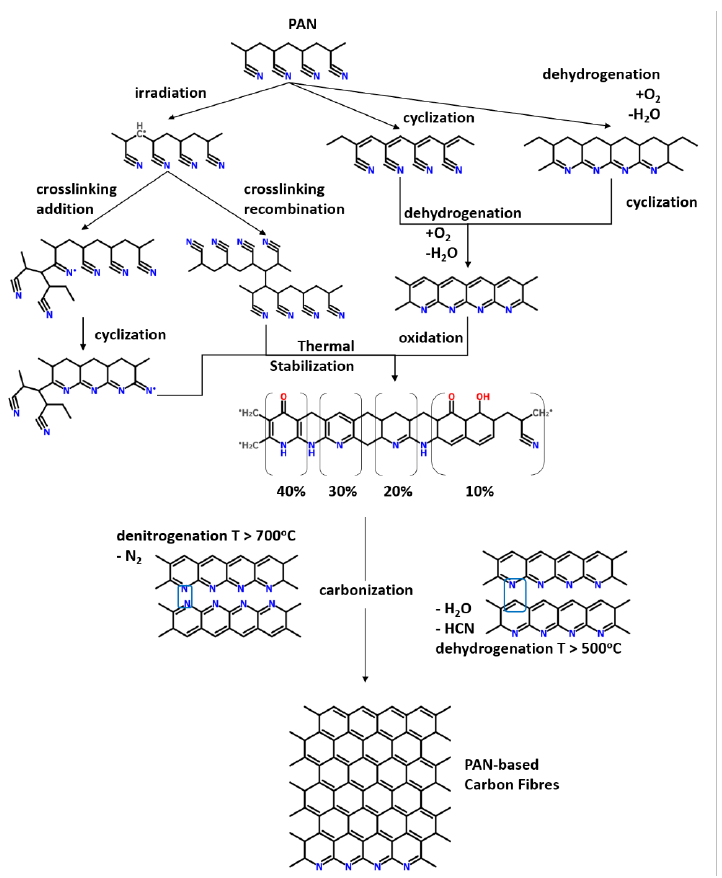
Figure 2. Chemical evolution of PAN fibers into carbon fibers.